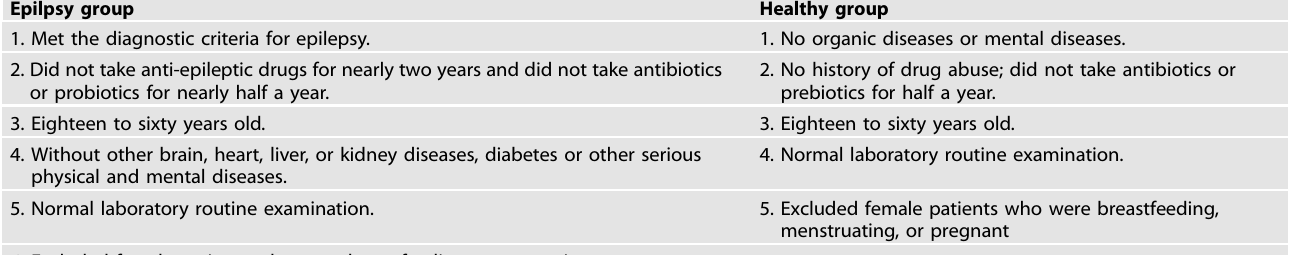
Table 2. The inclusion and exclusion